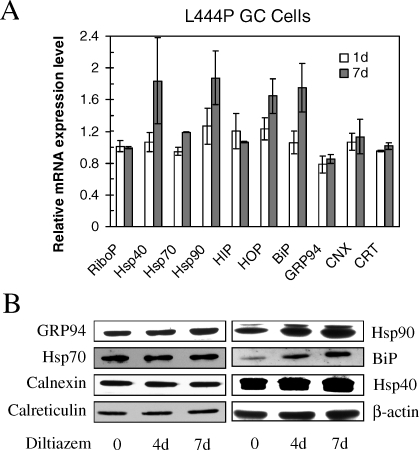
Chaperone Expression Level in Untreated and Diltiazem-Treated L444P GC Fibroblasts(A) Quantitative RT-PCR on untreated and diltiazem-treated L444P GC cells. L444P GC cells were incubated with 10 μM diltiazem for 1 d and 7 d. Relative mRNA expression level for diltiazem-treated L444P GC cells was normalized to that of untreated cells. Hsp40, Hsp70, Hsp90, HIP, HOP, BiP, GRP94, calnexin, and calreticulin were probed using corresponding primer pairs. Large ribosomal protein (RiboP) served as a housekeeping control.(B) L444P GC cells were treated with 10 μM diltiazem for 4 d and 7 d before being lysed for SDS-PAGE analysis. Hsp40, Hsp70, Hsp90, BiP, GRP94, calnexin, and calreticulin were probed using Western blot analysis. β-actin served as a loading control.